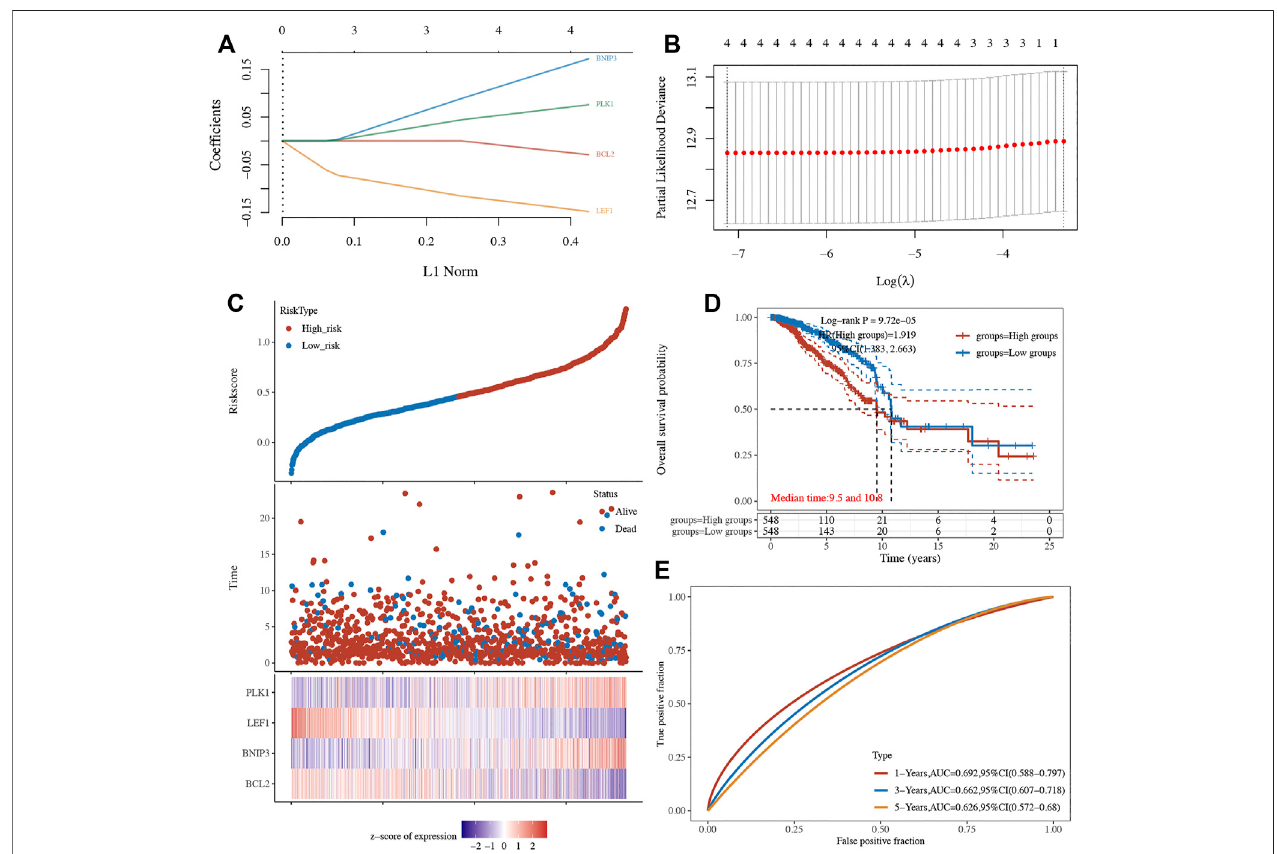
FIGURE 4 | Construction of a necroptosis-related prognostic signature. (A – B) The coef fi cient and partial likelihood deviance of prognostic signature. (C) The riskScoredistribution,survivalstatusofBRCAcases,andgeneexpressionpro fi leofthisprognosticsignature. (D – E) Overallsurvivalcurveinhigh/low-riskgroupandthe ROC curve evaluating prognosis predicting performance of BRCA